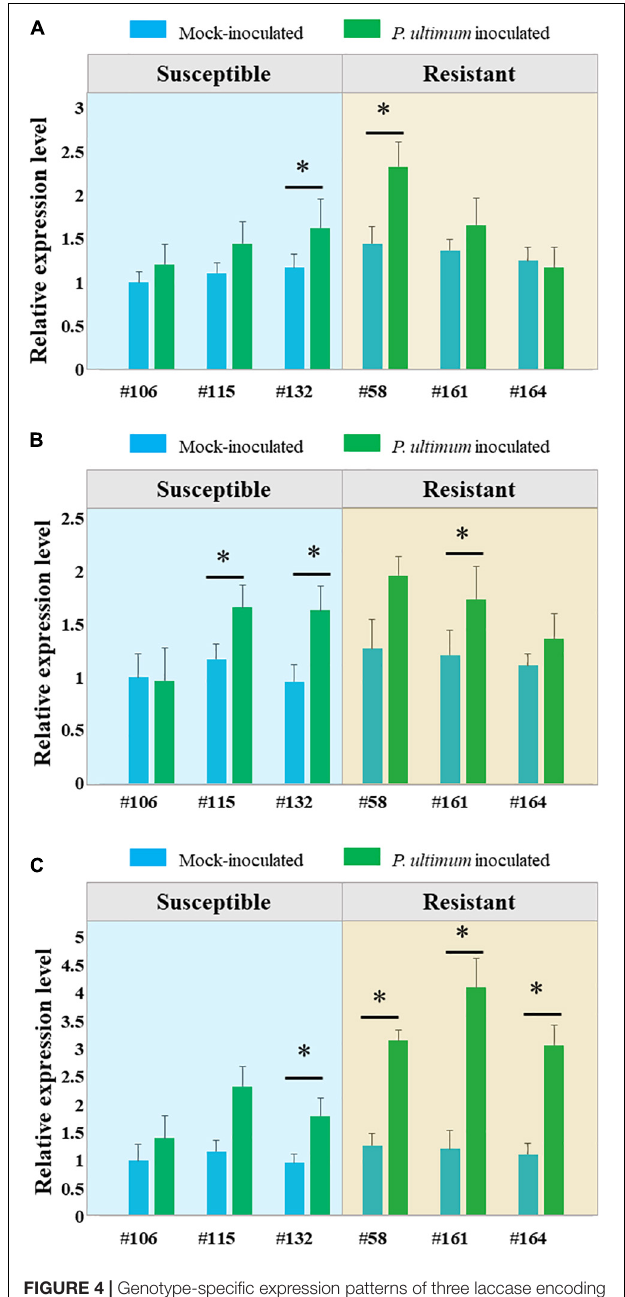
FIGURE 4 | Genotype-specific expression patterns of three laccase encoding genes in apple roots in response to Pythium ultimum infection. (A) Laccase-3; (B) Laccase-5 and (C) Laccase-7. The expression levels of these genes were measured by qRT-PCR. Genotypes are listed along X axis, with susceptible genotypes grouped at the left panel, and resistant genotypes grouped at right panel. Blue bar represents value of mock-inoculated root tissue and green bar represents the value of P. ultimum inoculated root tissue for each genotype. The values on Y axis represent the fold change of detected transcript level after normalizing to a reference gene (MD02G1221400) and calibrating by values of mock inoculated root tissue of the susceptible genotype #106. The values are the average of three biological replicates, and error bars are the standard deviation (SD) of fold changes. Error bars represent SE of three independent biological replicates. Asterisks denote statistically significant differences in a one-tailed Mann–Whitney U test ( ∗ P <